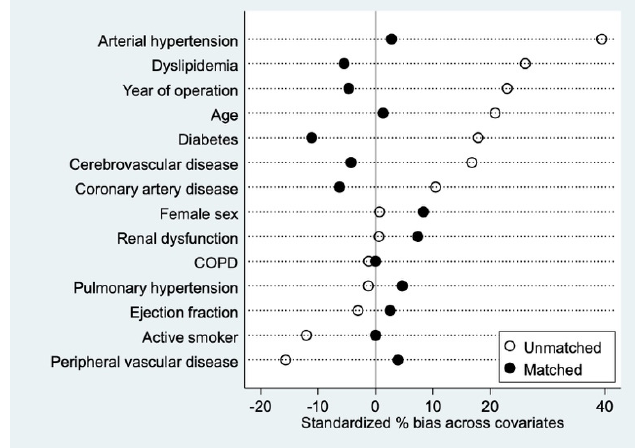
Figure 1. Bias before and after propensity matching.